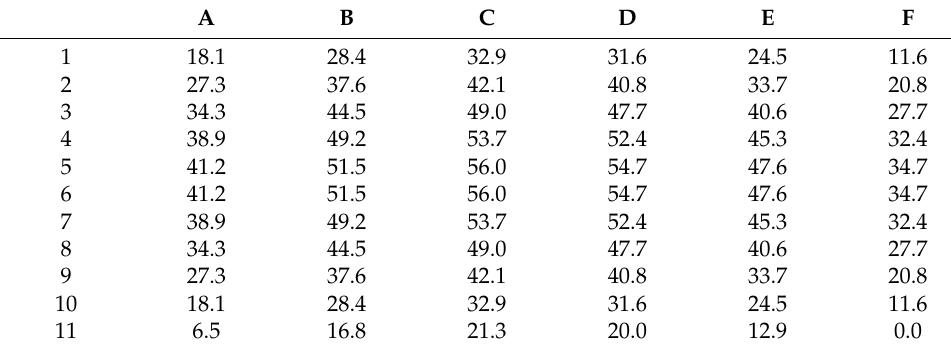
Table 4. Crowning amounts of the crowned work gear surface. (Unit: μ m).